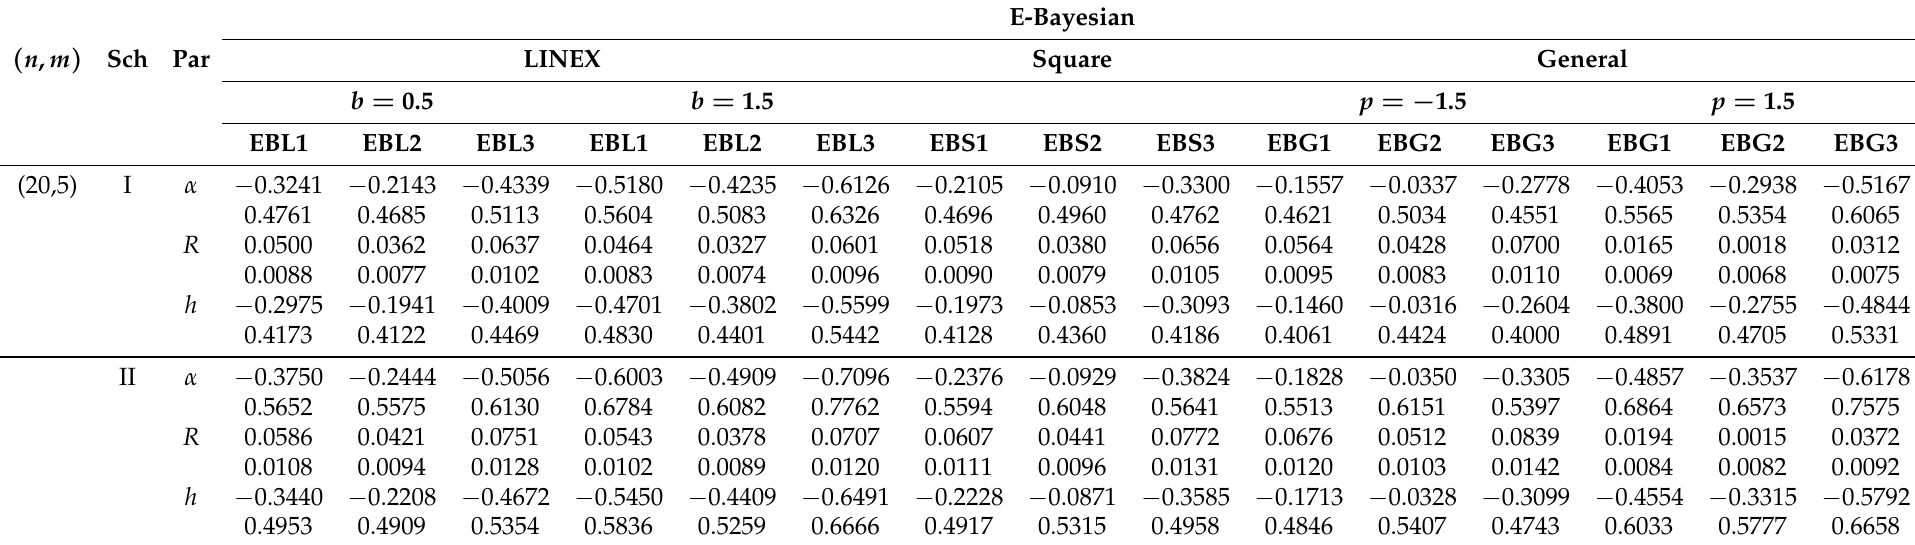
Table 2. Simulated biases (first row) and MSEs (second row) under different settings with α = 3.0, β = 1.5, τ = 0.5 and ω =